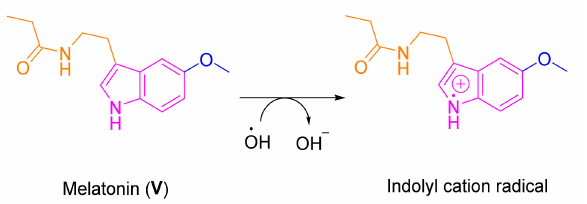
Figure 2. The electron-rich aromatic indole ring system of melatonin scavenges the hydroxyl radi- cal (HO • ).